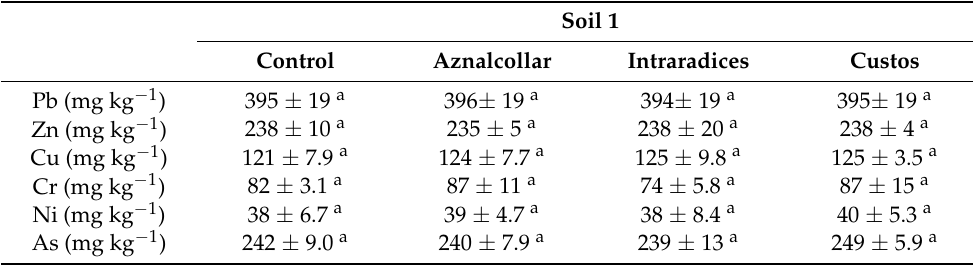
Table 1. Chemical characteristics of soil 1 (Control) inoculated with the three selected AMF (Aznal- collar, Intraradices, and